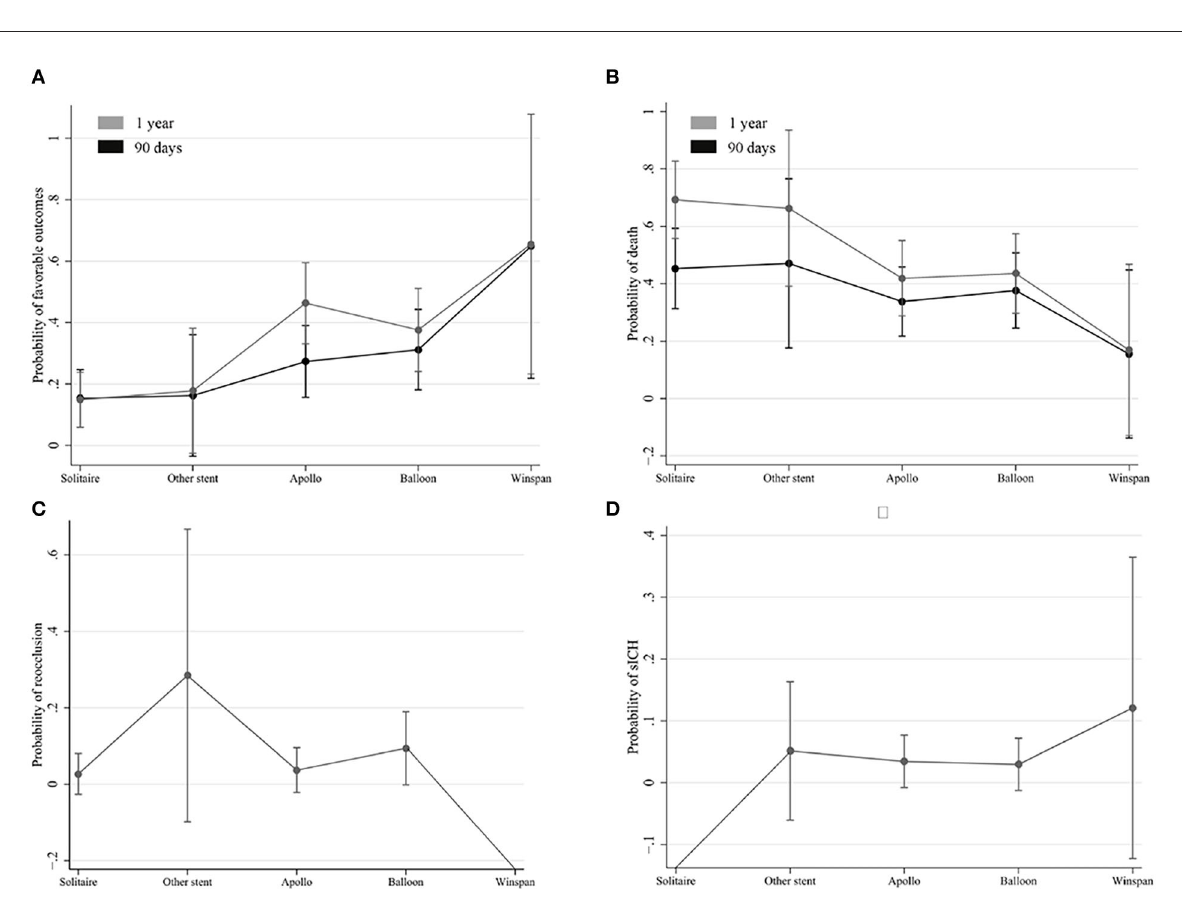
FIGURE2 Estimated marginal effects of favorable outcome probabilities on different rescue measures. The estimated marginal effects of favorable outcome probabilities (A) and mortality (B) on different rescue measures in 90 days and 1 year. The estimated marginal effects of reocclusion probabilities (C) and sICH (D) on different rescue